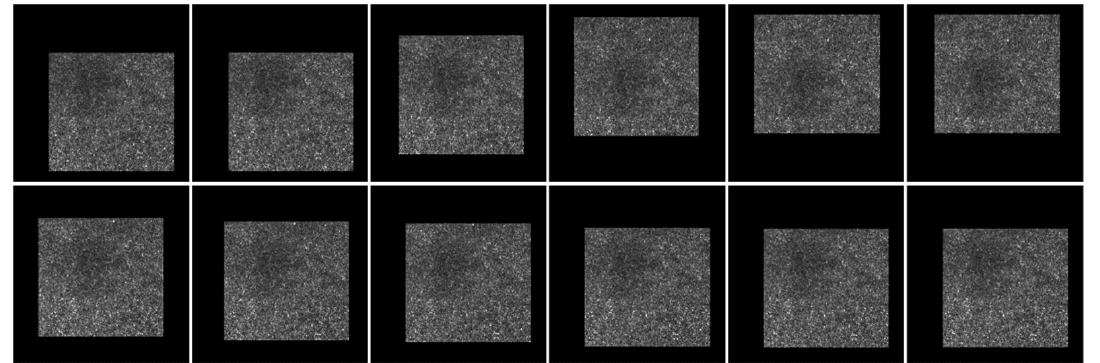
Figure 16. AOSLO images with fovea stabilization results. The first image is the first frame in the sequence.